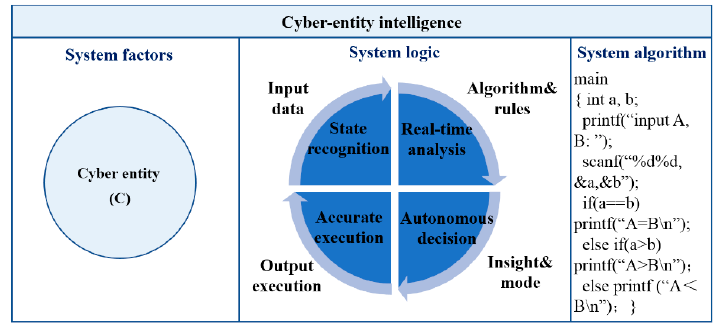
Figure 5. Cyber entity intelligence (Type I).